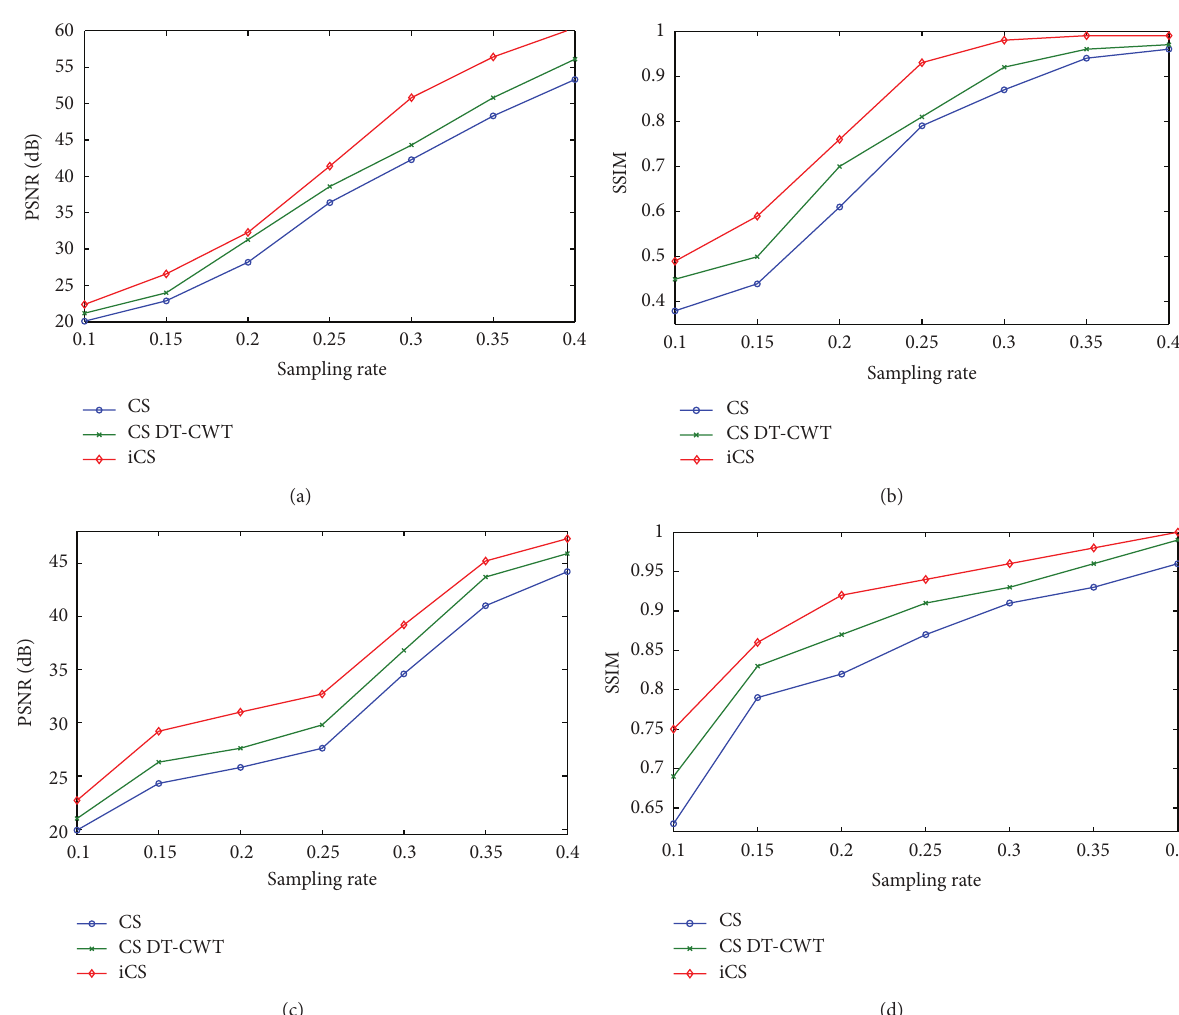
Figure 9: Plots of PSNR and SSIM versus different sampling rates. (a) PSNR of Shepp-Logan. (b) SSIM of Shepp-Logan. (c) PSNR of phantom dataset. (d) SSIM of phantom